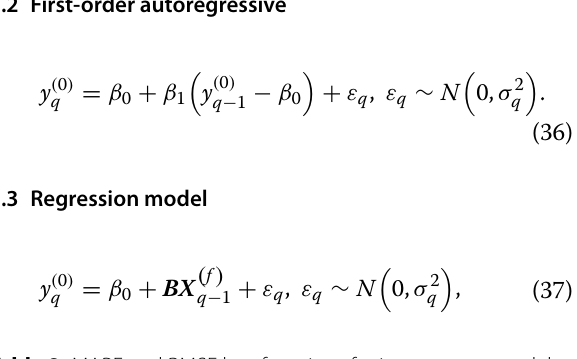
Table 8 MAPE and RMSE loss functions for investments